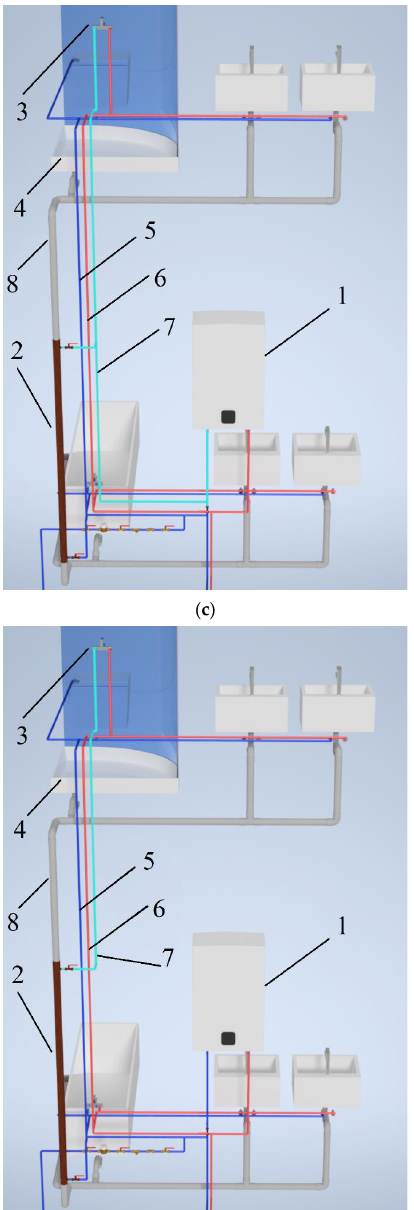
Figure 5. Examples of installation of a vertical heat exchanger: ( a ) Variant I—installation with DWHR heat exchanger and preheated water flowing to the water heater and shower mixing valve, ( b ) Variant II—installation with DWHR heat exchanger and preheated water flowing to the water heater, ( c ) Variant III—installation with DWHR heat exchanger and preheated water flowing to the shower mixing valve; 1—water heater, 2—DWHR heat exchanger, 3—shower mixing valve, 4—shower stall, 5—cold water pipe, 6—hot water pipe, 7—preheated water pipe, 8—waste